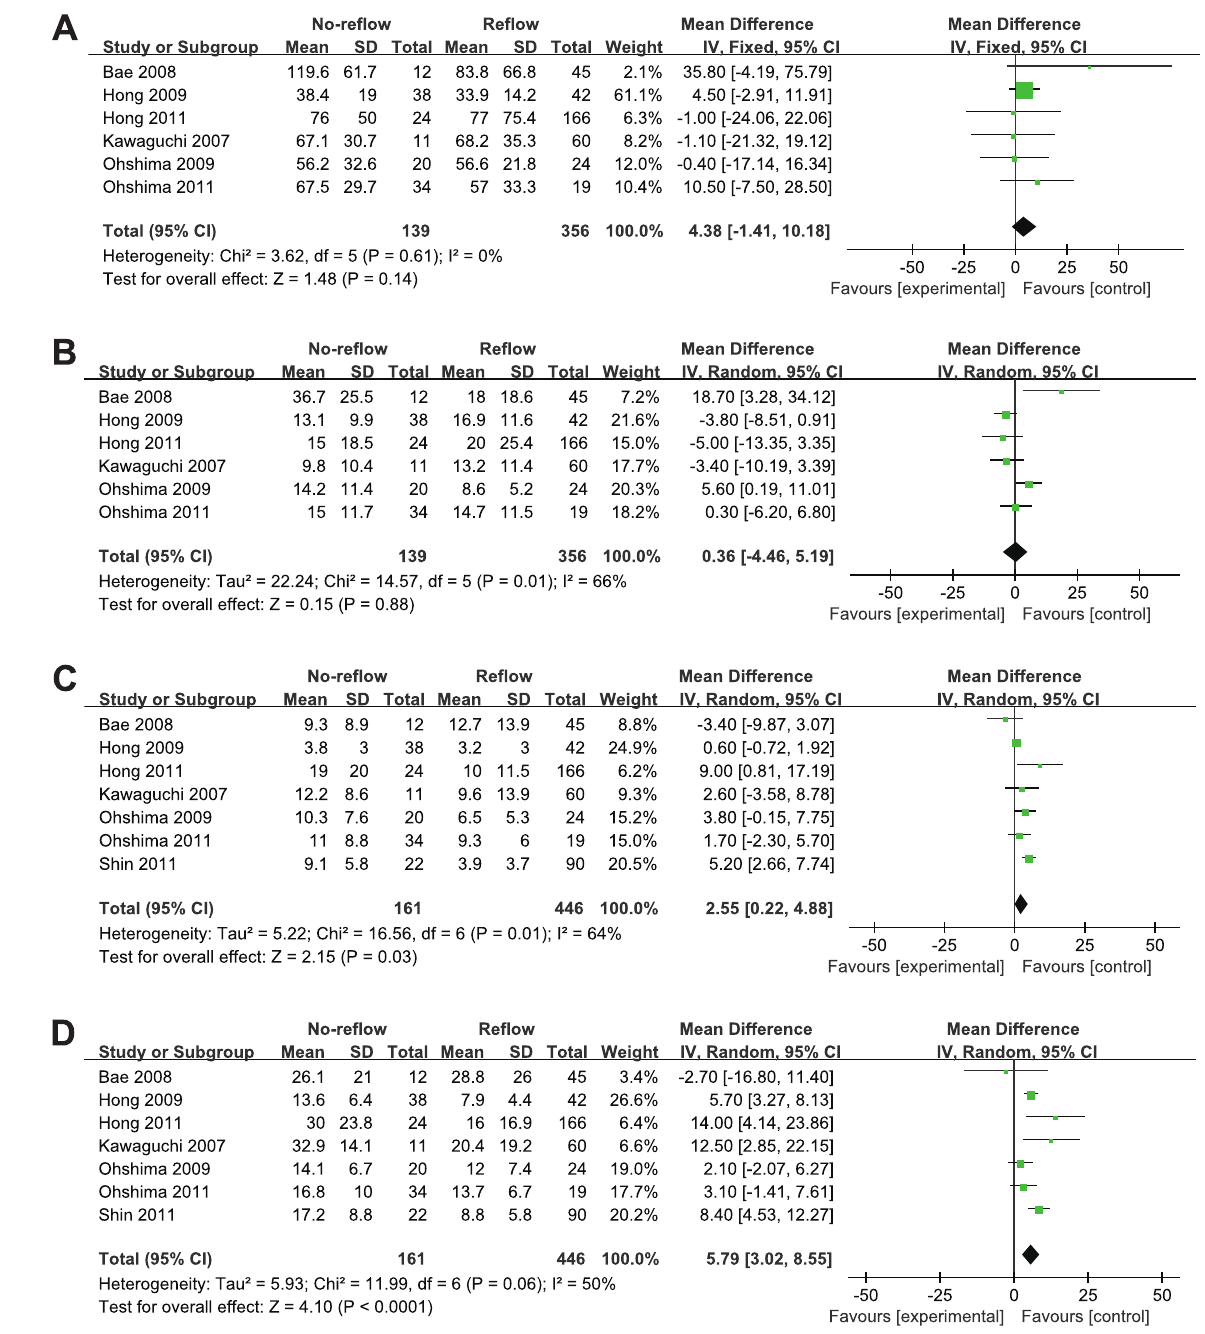
Figure 3. Absolute volume comparison of four different plaque compositions through the entire culprit lesion between the normal flow group and the distal embolization group. (A) Absolute fibrous volume comparison; (B) Absolute fibrofatty volume comparison; (C) Absolute dense calcium volume comparison; (D) Absolute necrotic core volume comparison;